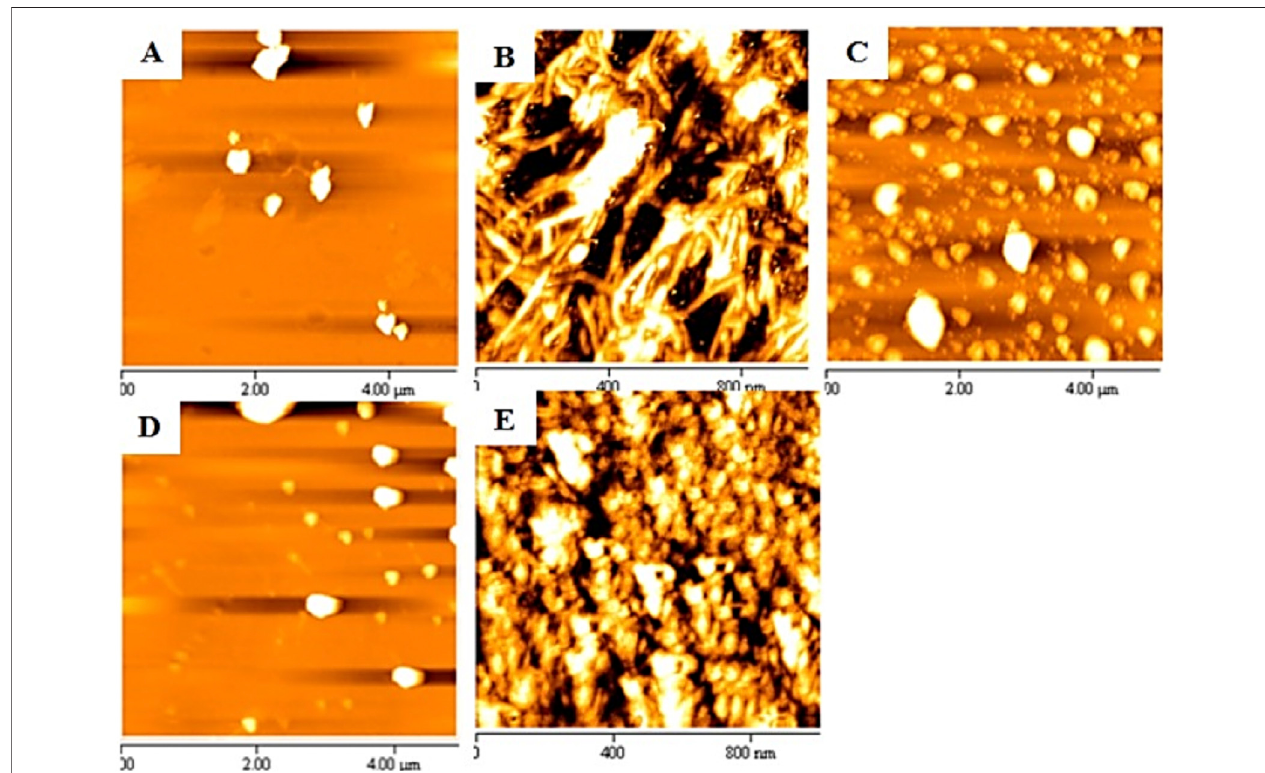
FIGURE 8 | AFM images of samples of tau protein incubated in the presence or absence of the volatile compounds Cin, PEA, and TEMED. The images show (A) not-heated tau protein, (B) not-treated tau protein, (C) tau protein treated with Cin, (D) tau protein treated with PEA, and (E) tau protein treated with TEMED.